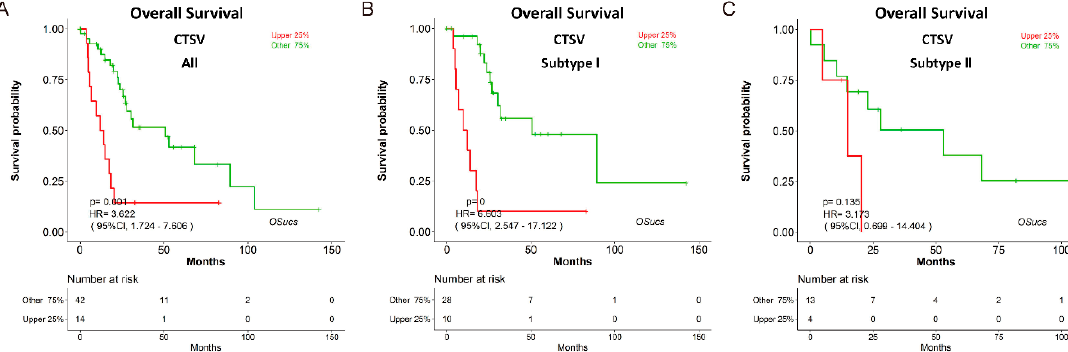
Figure 7. Evaluation of the prognostic value of cathepsin V (CTSV) in OSucs. Kaplan-Meier plots for CTSV in ( A ) All, ( B ) Subtype I, and ( C ) Subtype II UCS, respectively. p = 0 denotes p < 0.001.